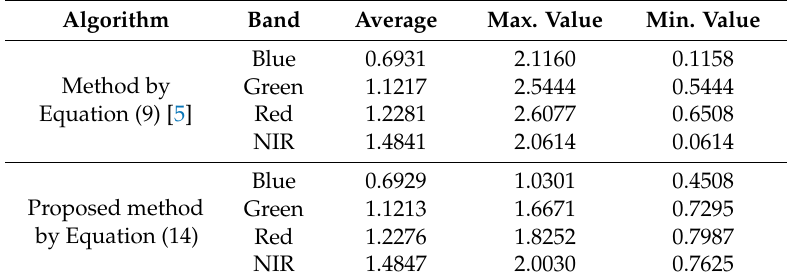
Table 5. Statistical characteristics of local injection gains according to algorithms used to extract the local injection